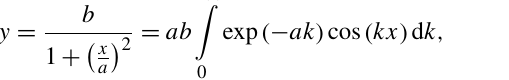
Figure 15. Sketch illustrating the linearisation of power-law flow law (black solid line indicates the exact flow law, τ xx = B(D xx ) 1 /n ) by using basic state variables ( ¯ τ xx , ¯ D xx ) and per- turbed variables ( e τ xx , e D xx ) . The reference viscosity at the point (cid:0) ¯ D (cid:1) for the basic state deformation, η xx , ¯ τ xx R , is related to the se- cant (represented by the blue line) at that point, while the viscosity for the perturbed deformation is related to the tangent (represented by the red line) at the point (cid:0) ¯ D xx , ¯ τ xx (cid:1) . The slope of the tangent is a factor n smaller than the slope of the secant at the same